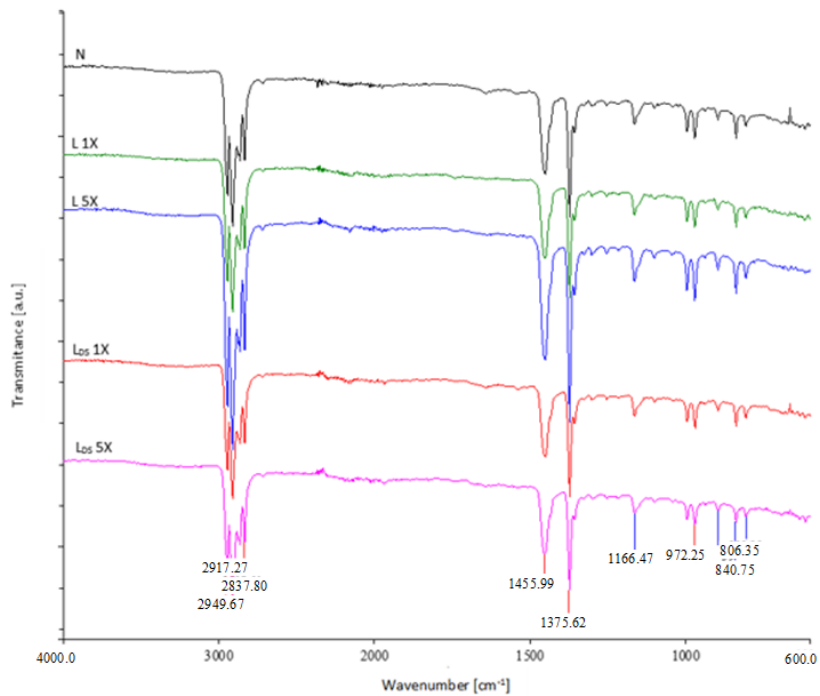
Figure 8. FTIR spectra of the front nonwoven layers of the medical mask before and after the first and fifth washing cycle.